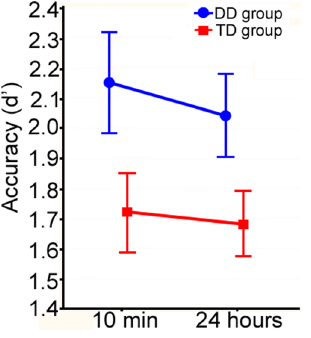
Figure 2. Adjusted means and standard errors for children with developmental dyslexia (DD) and typically developing control children (TD).